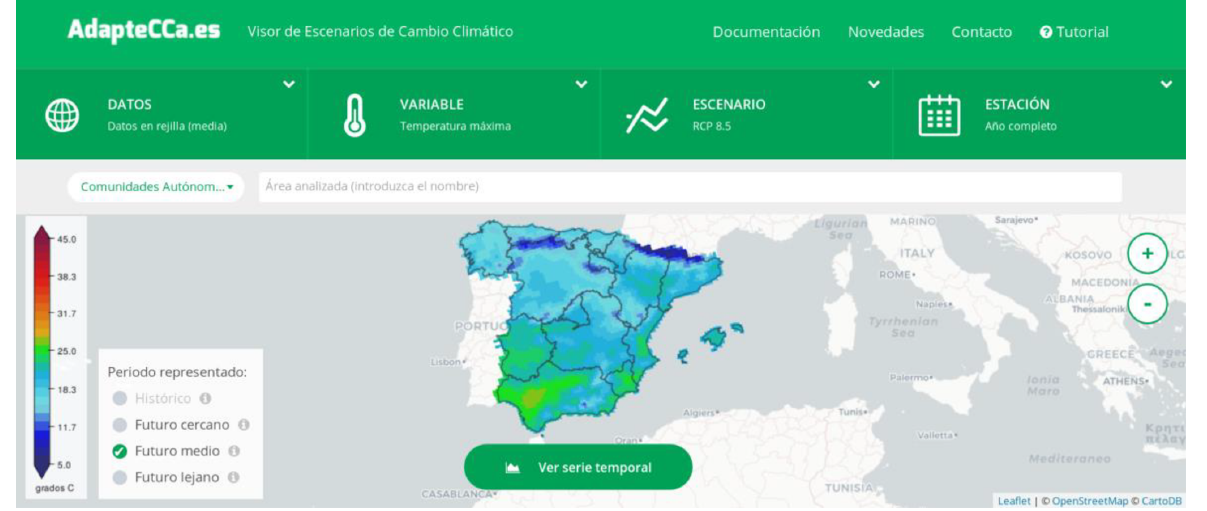
Figure 4. AdapteCCa Web portal (http://escenarios.adaptecca.es, last access: 2 August 2018). Date of screenshot: 2 August 2018.